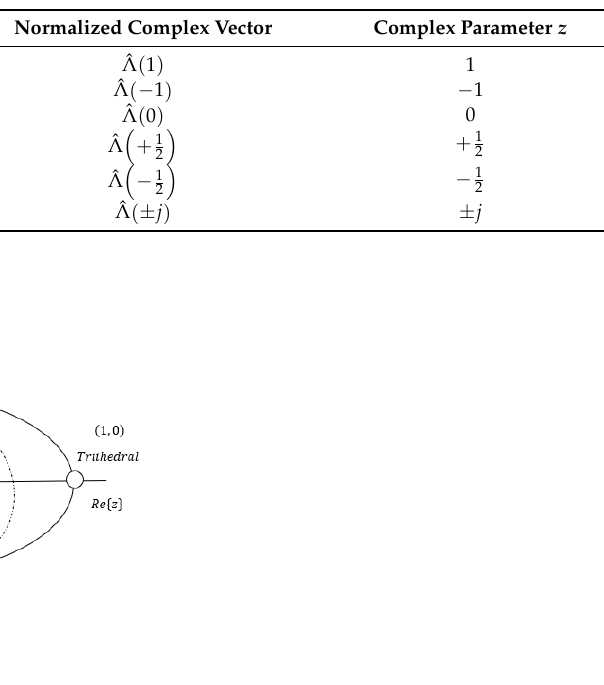
Figure 3. The position of the various types of elementary scattering mechanisms on Cameron’s unit disk representation.